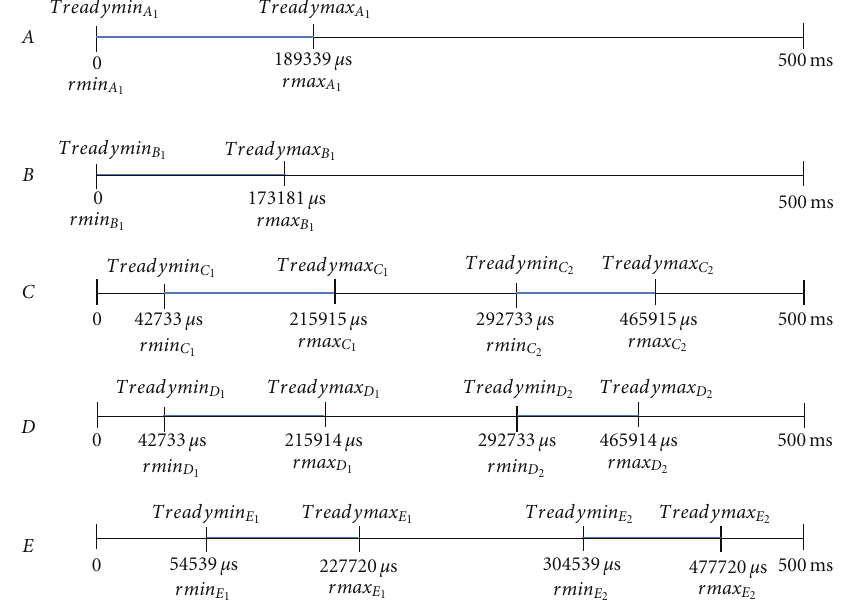
Figure 9: Treadymin and Treadymax of tasks in the DAG.